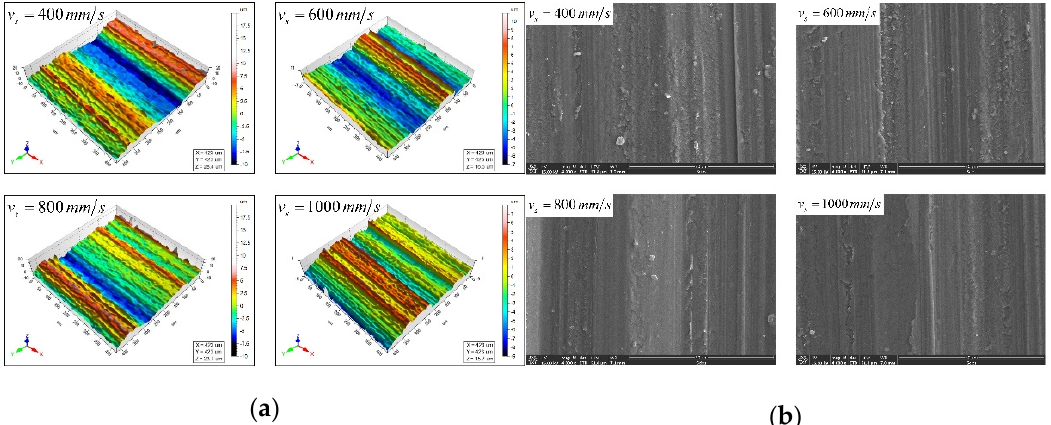
ing depths: 6 µ m, Feed rates: 200 mm/min). Figure 12. Effect of grinding wheel linear speed on the three-dimensional surface roughness. (Grind-